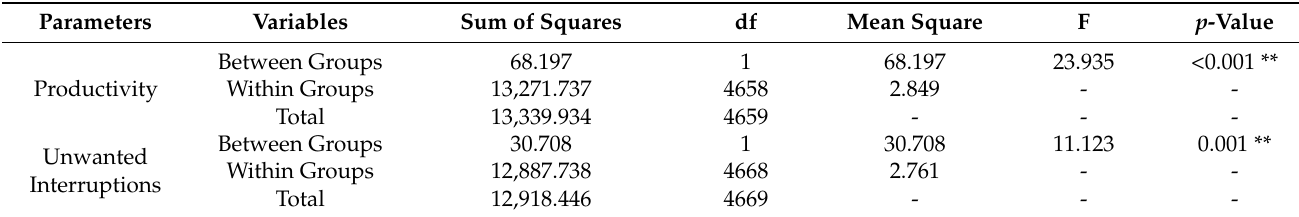
Table 14. One-way ANOVA analysis comparing productivity and unwanted interruptions for male and female gender groups.